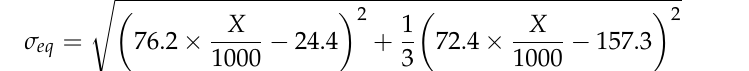
Figure 11. The stress distribution of crankshaft N0 (under the given bending moment).